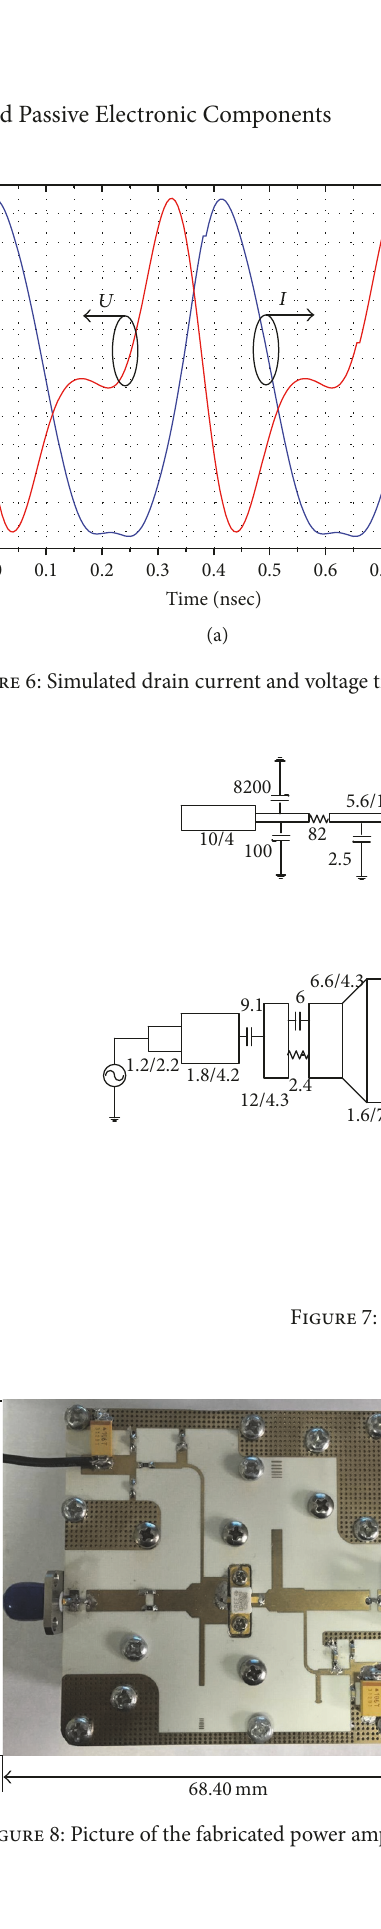
Figure 8: Picture of the fabricated power amplifier.